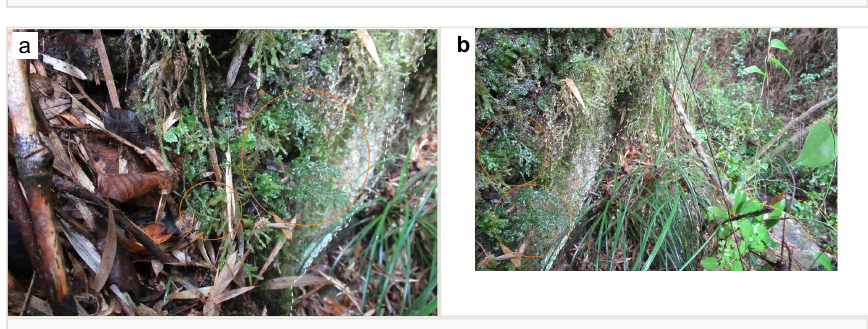
Figure 2. Photographs of the site where the species was found. The dotted white line represents the rock's visual boundary and yellow dotted line represents the stream. The orange circles delimit some fronds of H. caudatum